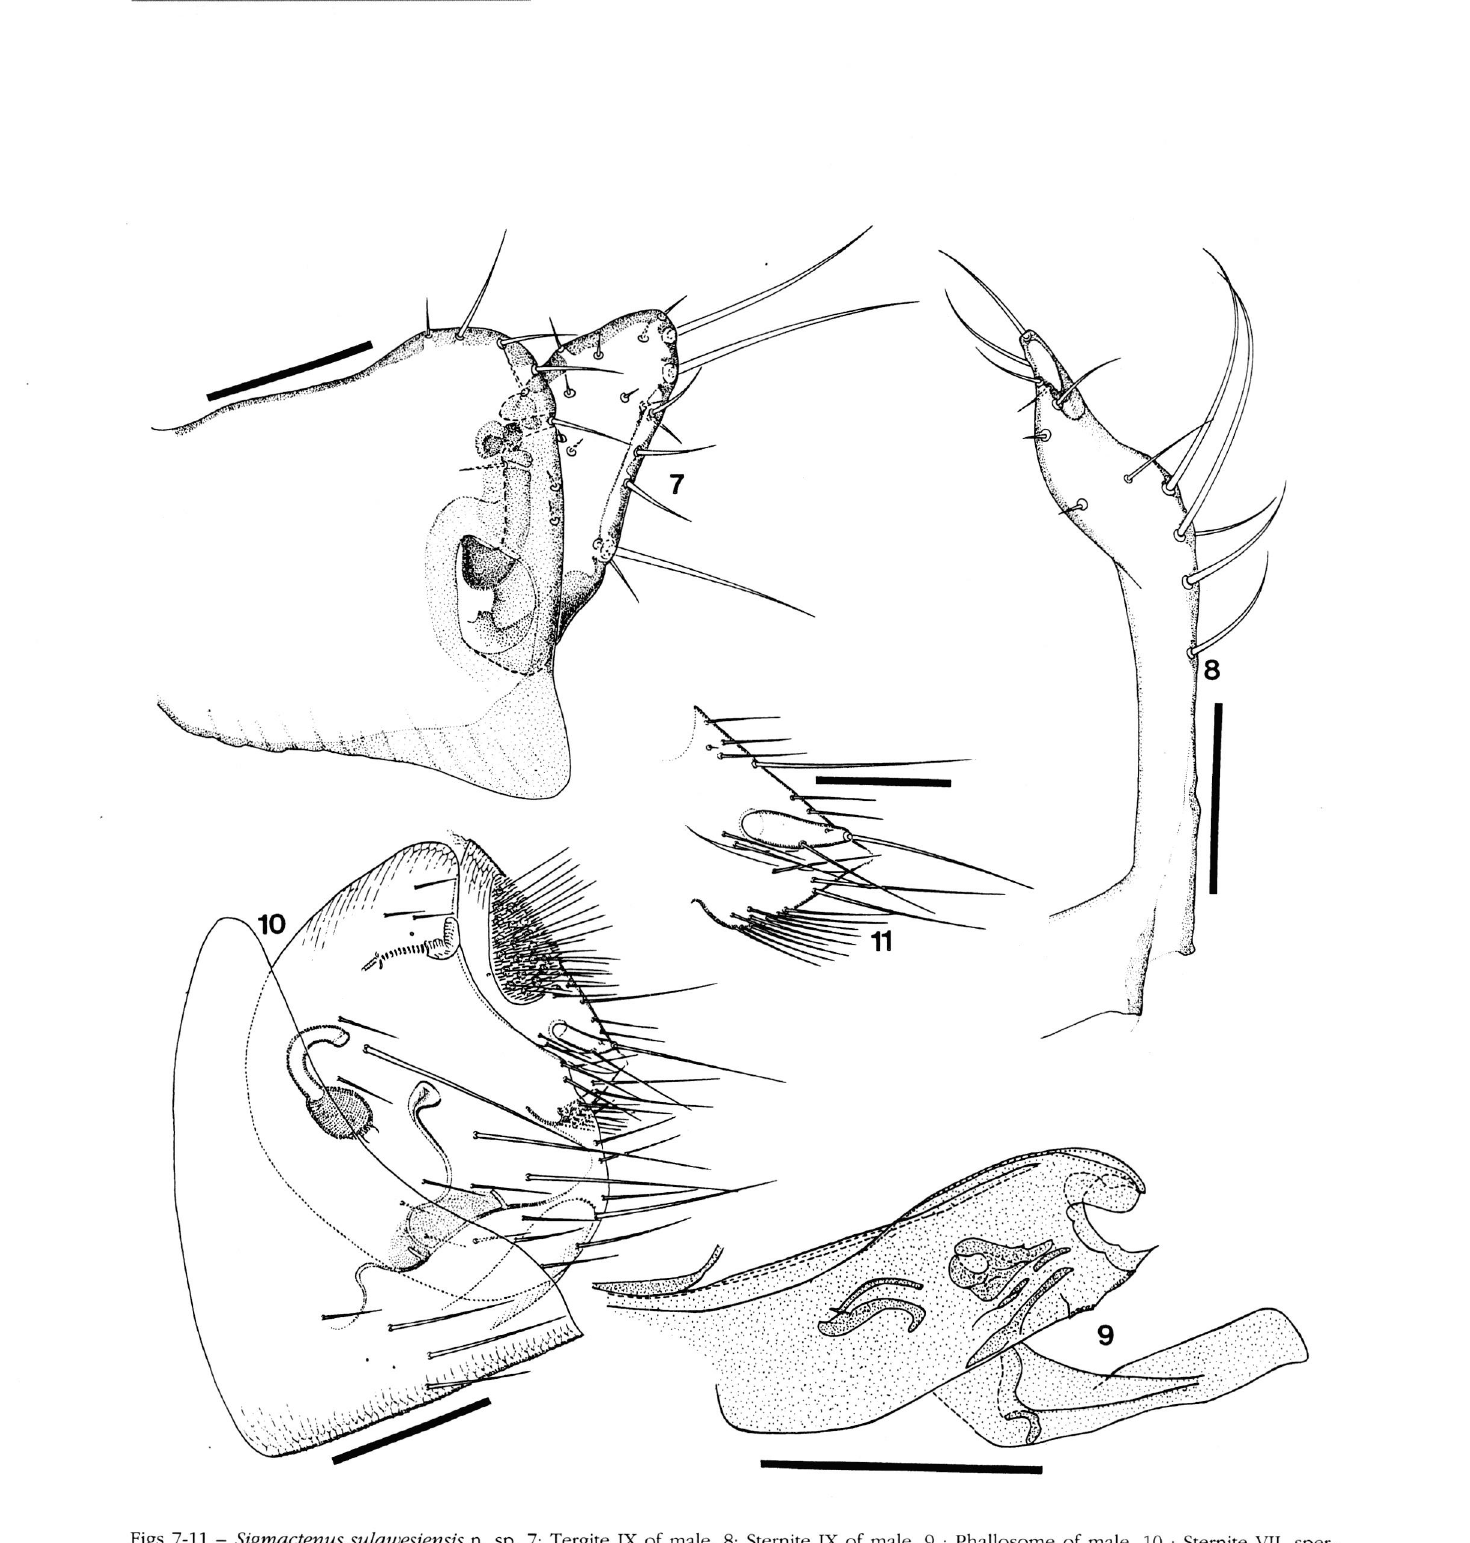
Figs 7-11 - Sigmactenus sulawesiensis n. sp. 7: Tergite IX of male. 8: Sternite IX of male. 9 : Phallosome of male. 10 : Sternite VII, sper- matheca and adjacent structures of female. 11: Anal valves and anal stylet of female. All scale bars = 0,1 mm.